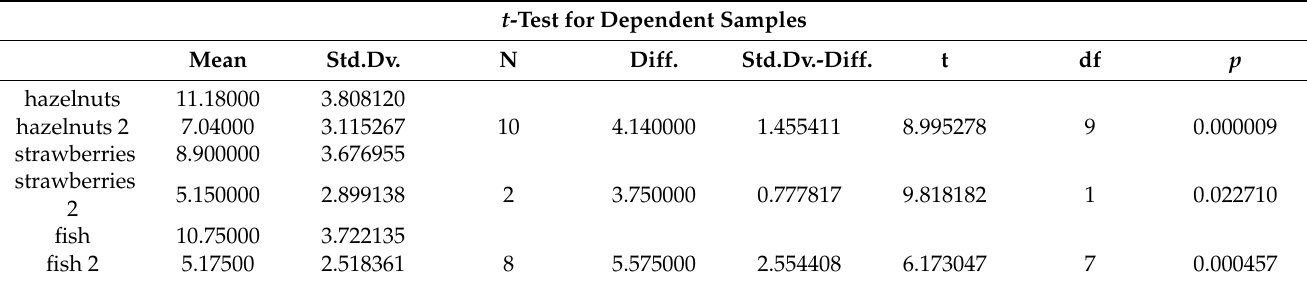
Table 4. Comparison of dynamic mean values for specific IgE of hazelnuts, strawberries, and fish. t -Test for Dependent Samples